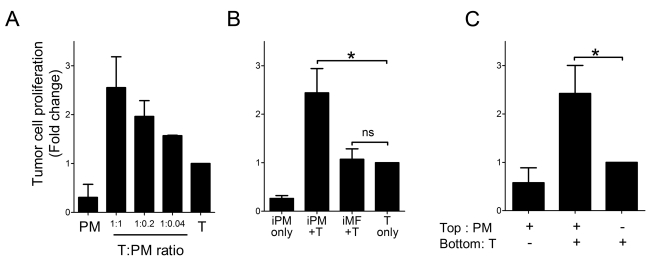
PMN-MDSC favor tumor cell proliferation in vitro.(A) Melan-ret cells (5×103 cells per well) were cultured with increasing concentrations of PMN-MDSC purified from tumor-bearing RETAAD mice (12-wk-old) for 48 h. Proliferation of tumor cells was assessed by [3H]-thymidine incorporation. PM, PMN-MDSC only; T:PM, ratio of tumor cells to PMN-MDSC; T, tumor cells only. (B) Irradiated PMN-MDSC but not macrophages induce Melan-ret tumor cell proliferation. Macrophages and PMN-MDSC were irradiated at 2,000 rads before co-culture with tumor cells for 48 h. iPM, Irradiated PMN-MDSC; iMF, Irradiated macrophages; T, tumor cells. (C) PMN-MDSC-induced proliferation does not require direct contact. PMN-MDSC and tumor cells were plated in the top and bottom wells of transwell inserts (pore size=0.4 µm; Millipore), respectively. PMN-MDSC cultured in the upper chamber were able to induce proliferation of Melan-ret tumors cells in the bottom chamber after 48 h. Data are from four independent experiments carried out in duplicates. Bars represent the average fold change relative to tumor cell only ± SEM. *p value <0.05, two-tailed paired Student’s t test.